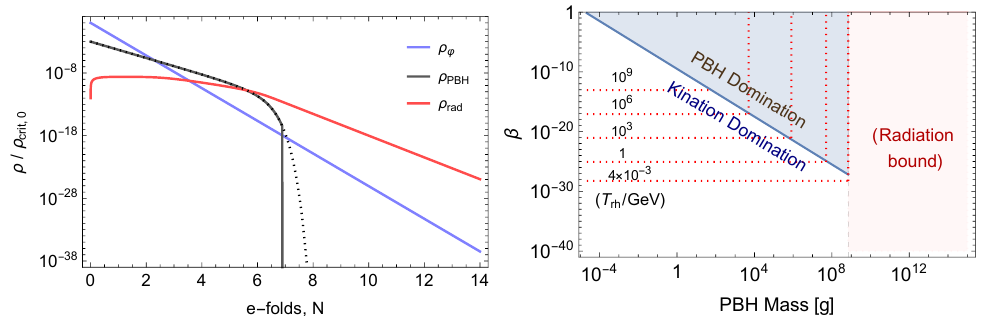
Figure 3. In the left panel the evolution of the energy densities of a runaway scalar field, PBHs and radiation, ρ ϕ , ρ PBH and ρ rad , respectively, normalized by the initial critical energy density ρ crit, 0 , are shown for a transit PBH domination phase. The runaway scalar field is modeled as a stiff fluid, the PBHs initially evolve as a pressureless fluid but they promptly evaporate producing radiation. The truncation of the PBH evolution is dictated by Equation (16); for comparison the effect of a constant in time decay rate is also depicted. The radiation initially evolves as N and after the completion of the evaporation as e − 4 N . In the right panel we depict the β values that a PBH domination phase is realized/avoided for a background dominated by stiff fluid. We also contour plot five values of the reheating temperature due to PBH